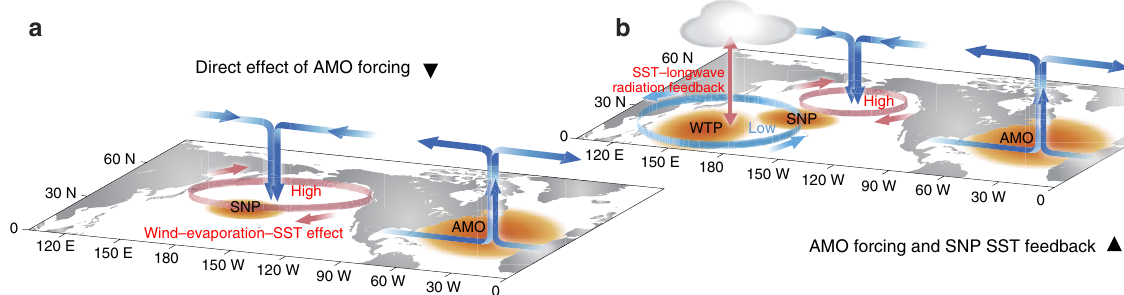
Figure 7 | Schematic diagram for the teleconnection between Atlantic multidecadal oscillation and western tropical Pacific decadal variability. ( a ) The direct effect of Atlantic multidecadal oscillation (AMO) forcing on North Pacific. The AMO warm SST anomaly (the orange patch over North Atlantic) generates anomalous ascent and upper-level divergence over North Atlantic. The associated upper-level outflows converge towards North Pacific, leading to compensating subsidence along with an anomalous high there, which weakens the Aleutian low and decreases the wind speed of subtropical North Pacific (SNP) westerlies. The wind changes induce a SNP SST warming (the orange patch over subtropical North Pacific) through wind–evaporation–SST effect. ( b ) The combined effects of AMO and SNP SSTwarming feedback. In response to the SNP SSTwarming, the surface winds converge towards the SNP SST warming centre from the tropics, leading to an anomalous cyclonic circulation and low pressure over the western tropical Pacific region. The teleconnection further develops into to a SST warming pattern (the orange patch over western tropical Pacific) due to the SST–sea level pressure–cloud– longwave radiation positive feedback (shown as ‘SST–longwave radiation feedback’ in the